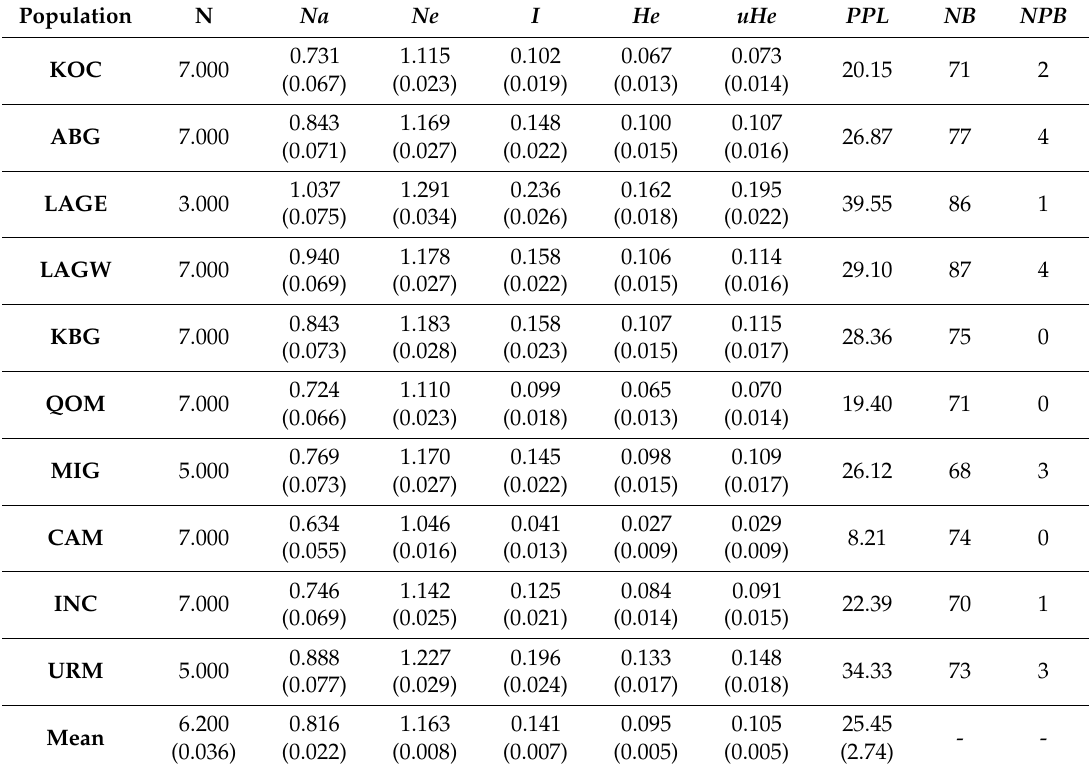
Table 5. Genetic indices among native populations according to ISSR markers.